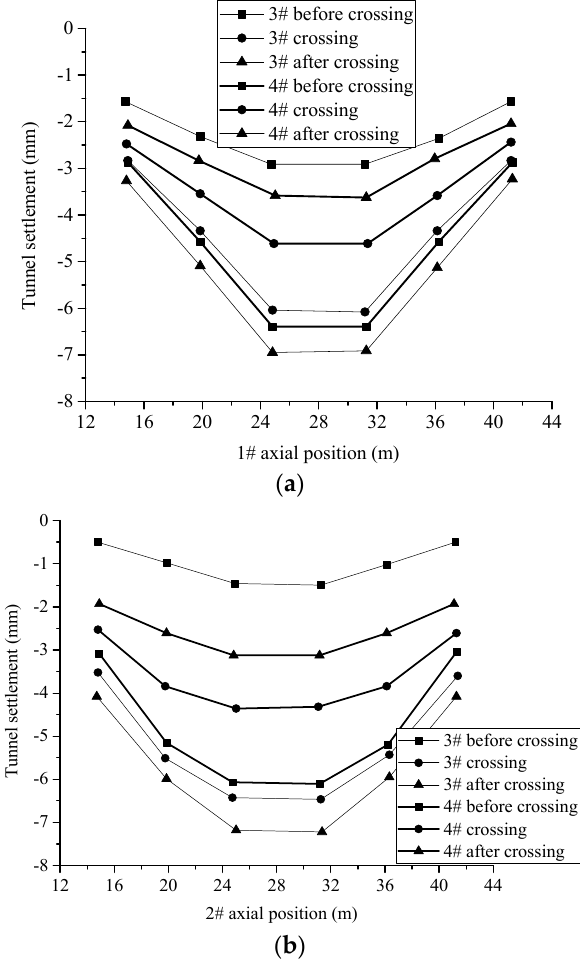
Figure 14. The longitudinal displacement of the existing tunnels, ( a ) No. 1 and ( b ) No. 2, under the condition of first-down and then-up crossing.